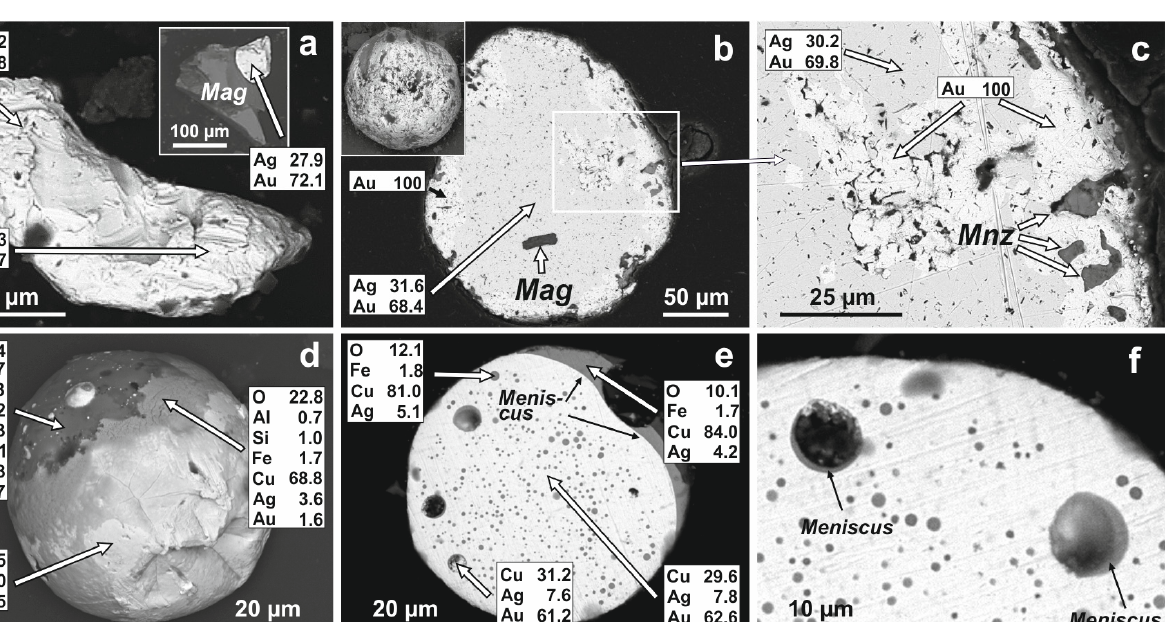
Figure 9. Gold-silver alloys and associated minerals in ores and explosive breccia from the Poperechnoye deposit: ( a – c )— high purity gold of variable shape ( a ), subhedral (with retained crystal faces) ( b ) and rounded ( c ); ( d , e )—gold grains in magnetite ore; ( f )—native bismuth overgrowth on gold grain. Chemical analyses of alloys and minerals in all figures are in wt.%. Arrows indicate precise location of SEM-EDS data points.